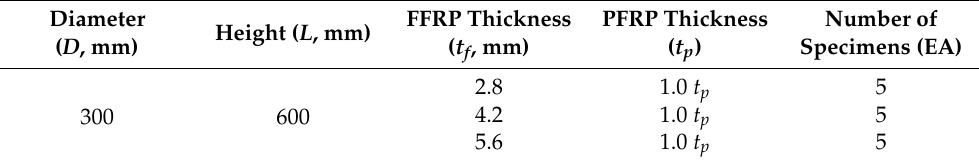
Table 5. Experimental variables of the PFRP − FFRP specimen.